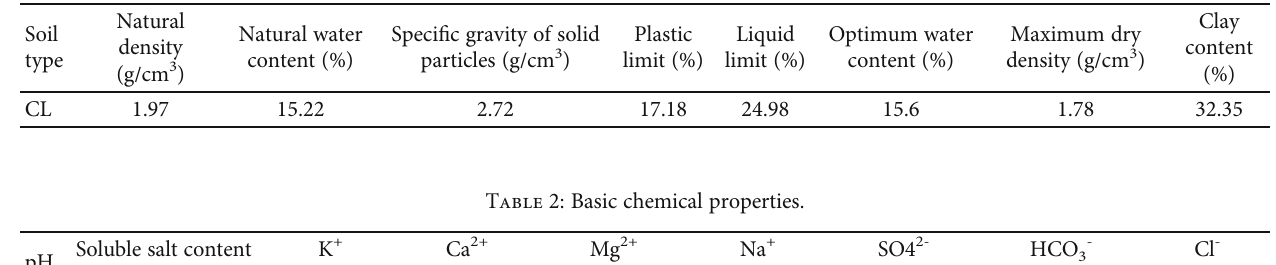
Table 1: Basic physical properties.